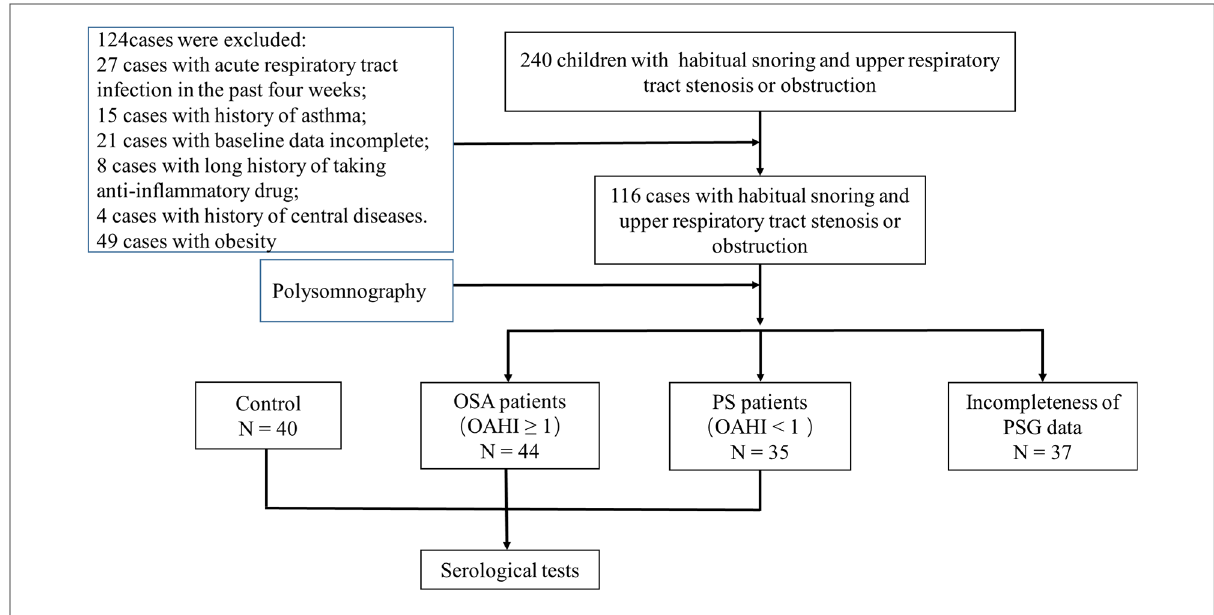
FIGURE 1 Summary of subject